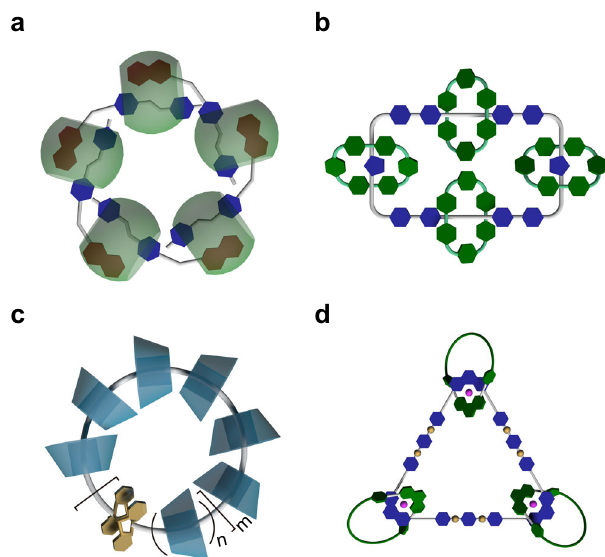
Fig. 1 Cartoon representations of the selected previously reported molecular necklaces. a [6]MN reported by Kim et al. 34 , b [5]MN reported by Stoddart et al. 35 , c [ n ]MN reported by Harada et al. 36 , and d [4]MN reported by Yang et al. 37